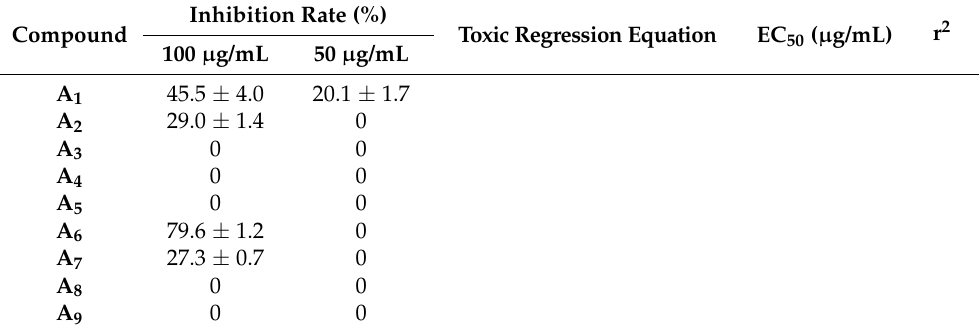
Table 6. The in vitro antibacterial activities of target compounds against plant pathogen Xoo